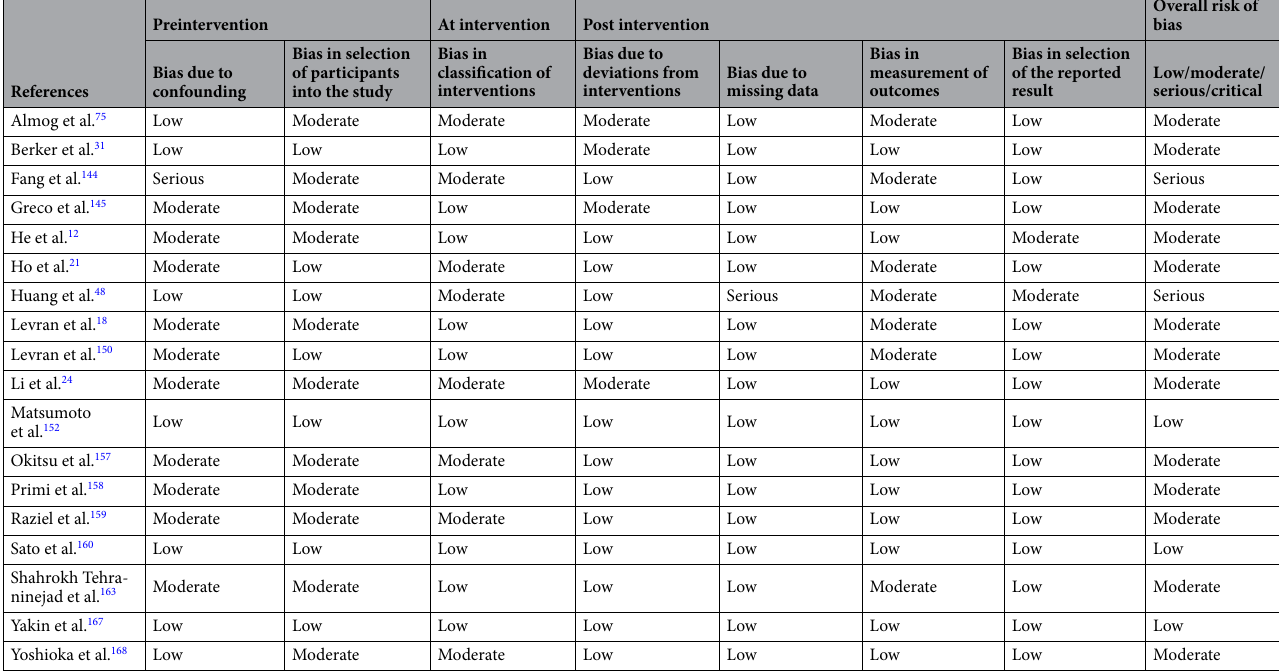
Primary outcomes Meta-analysis did not show increased chances of clinical pregnancy (random effects model, OR 2.40; 95% CI 0.52–11.05; p = 0.26; I 2 = 87%) 18,150,163 and live birth (random effects model, OR 3.43; 95% CI 0.03–43.80; p = 0.62; I 2 = 91%) in women who underwent ZIFT (Fig. 4). Secondary outcomes Pooling of results failed to show a benefit on embryo implantation chances (random effects model, OR 3.73; 95% CI 0.69–20.27; p = 0.13; I 2 = 64%) 18,150 . MPR resulted significantly lower in women who underwent ZIFT (OR 0.26; 95% CI 0.07–0.91; p = 0.04) 163 . Shahrokh Tehraninejad et al. did not observe an impact on MR (OR 2.09; 95% CI 0.70–6.21; p = 0.19) 163 . Quality of the evidence The quality of the evidence was downgraded by one level for risk of bias (Table 4). AH. One RCT 153 and one observational study 158 investigated the effect of AH on IVF outcomes in women with RIF. Primary outcomes 156 did not observe an increased chance of clinical pregnancy in women who underwent AH (RR 0.78; 95% CI 0.48–1.27; p = 0.31) 153 (Fig. 4). Primi et al., confirmed this finding (CPR, OR 1.42; 95% CI 0.45–4.48; p = 0.55) and failed to show a beneficial effect also on chances of live birth (OR 1.92; 95% CI 0.48–7.67; p = 0.36) 158 (Fig. 4). Secondary outcomes Primi et al. did not observed any difference in MPR between groups (OR, 1.49; 95% CI 0.09–24.44; p = 0.78) 158 . Quality of the evidence The quality of the evidence provided by Rufas-Sapir et al. was downgraded by one level for risk of bias and, considering the low number of events, by one level for imprecision 2 . We downgraded the quality of the evidence emerged from the study conducted by Primi et al. , by one level for risk of bias (Table 4). Immunomodulatory therapies. G-CSF administration. Six RCTs evaluated the possible beneficial effect of the subcutaneous or intrauterine G-CSF administration 140,142,147,148,161,162 . Primary outcomes Pooling of results from studies showed increased chances pregnancy in treated subjects (fixed effects model, 1.94; 95% CI 1.47–2.55; p < 0.00001; I 2 = 0%) 140,142,147,148,161,162 . Only one study investigated the impact of intrauterine G-CSF infusion on the chances of live birth and failed to show a benefit (RR 0.84; 95% CI 0.41–1.73; p = 0.64) 147 . Secondary outcomes Two trials reported implantation rate. Pooling of results showed a beneficial effect (fixed effects model, RR 2.41; 95% CI 1.38–4.22; p = 0.002; I 2 = 0%) 140,142 . Kalem et al. did not observe any impact on MR (RR 3.20; 95% CI 0.69–14.93; p = 0.14) 147 . Subgroup analysis Subcutaneous and intrauterine route of administration were analyzed separately (Fig. 3). Subcutaneous G-CSF administration resulted associated with an increased chance of clinical pregnancy (fixed effects model, RR 2.29; 95% CI 1.58–3.31; p < 0.0001; I 2 = 0%) when compared with no treatment 140,148,161,162 (Fig. 3). On the contrary, intrauterine administration had no impact on CPR (fixed effects model, RR 1.53; 95% CI 1.00–2.33; p = 0.05; I 2 = 0%) 142,147 (Fig. 3). Aleyasin et al. who investigated the subcutaneous route of admin- istration observed a positive effect on embryo implantation chances (RR 2.94; 95% CI 1.24–5.01; p = 0.01) 140 .